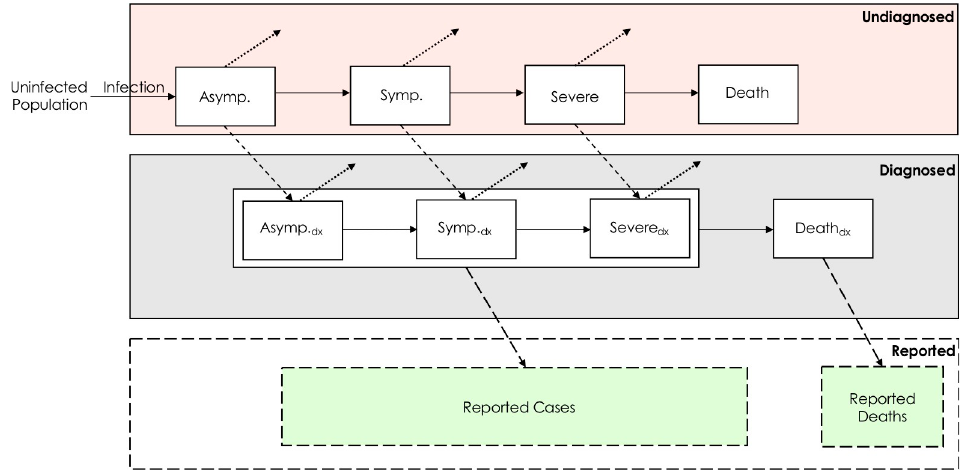
Fig 1. A model schematic of the main health states: Asymptomatic (denoted “Asymp.”), Symptomatic (denoted “Symp.”), Severe , and Death . The subscript “dx” indicates that individuals in that state have received a diagnosis of COVID-19. Each transition (denoted with an arrow) has an associated probability and delay distribution. Solid arrows denote disease progression; dotted arrows denote recovery; short dashed arrows denote diagnosis; long dashed arrows denote reporting. All diagnosed cases and deaths are assumed to be reported after a given